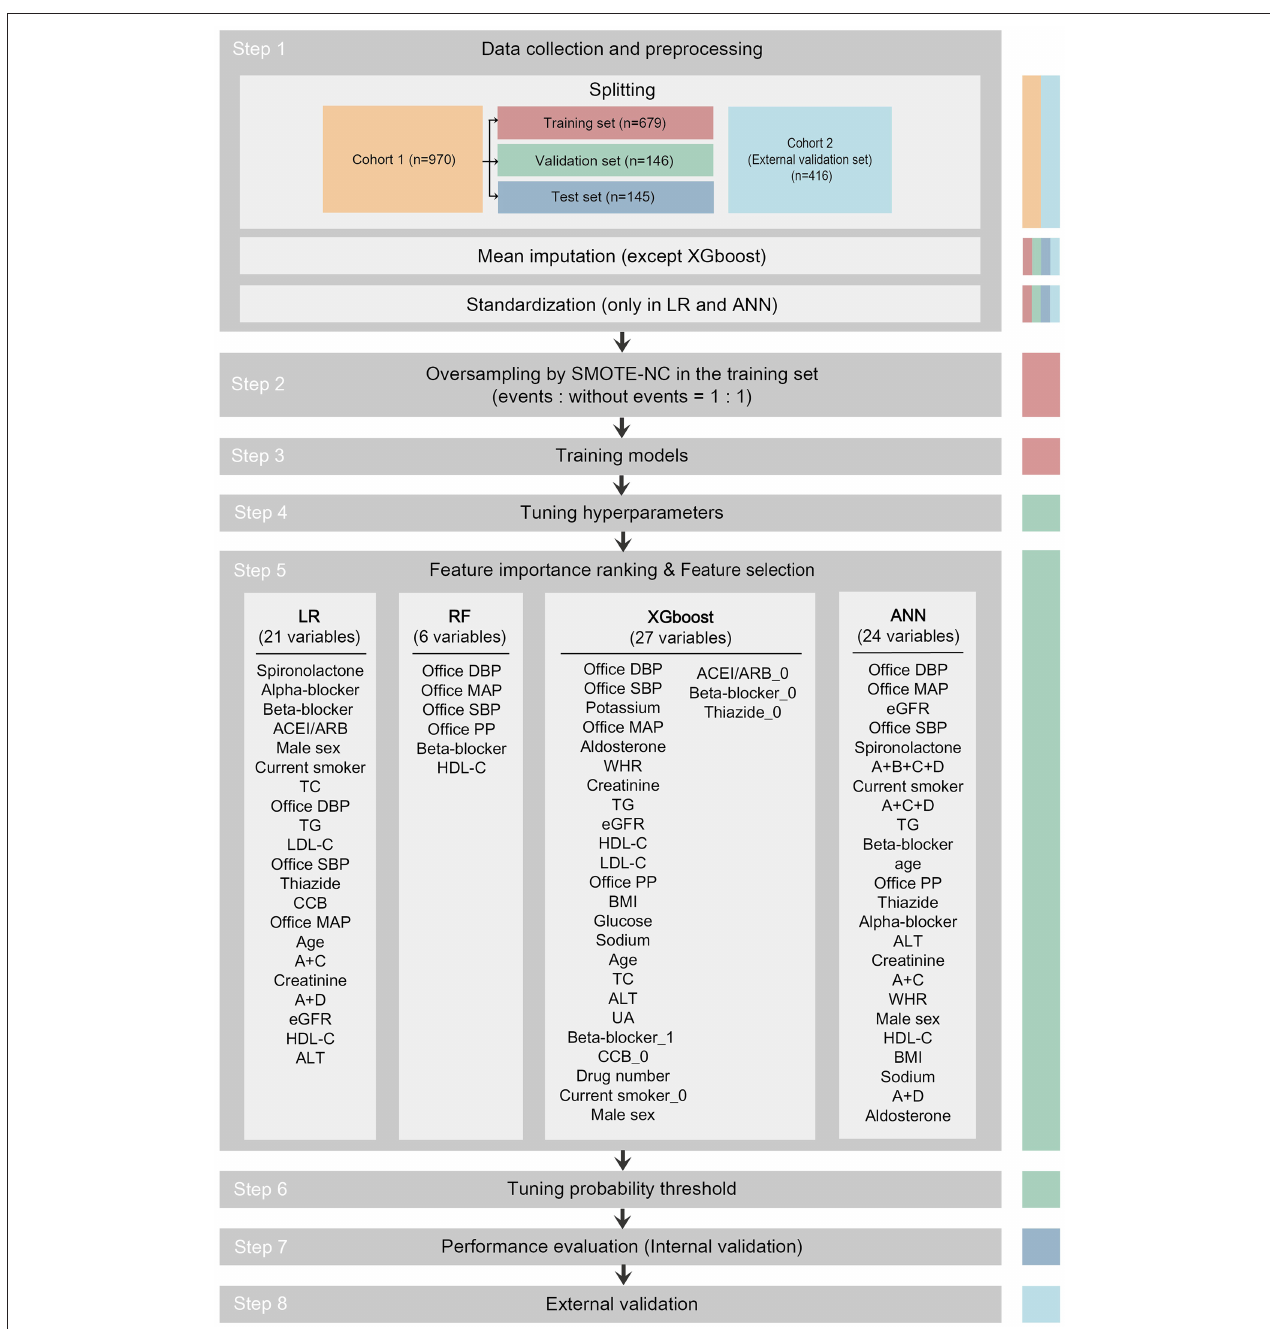
FIGURE 1 | Study flowchart. The data set used in each step is indicated as colored columns on the right side (training set for step 2 and 3, validation set for step 4 to 6, test set for step 7, cohort 2 for step 8). Mean imputation was done to all data sets using the mean of the training set in the LR, RF, and ANN models after splitting. Standardization was done to all data sets in the LR and ANN models after mean imputation. In step 5, 21 among 33 candidate variables were selected as predictor variables in the LR model, 6 in RF, 27 in XGboost, and 24 in ANN. The predictor variables were written in descending order of importance. ACEI/ARB, angiotensin-converting enzyme inhibitor/angiotensin receptor blocker; ACEI/ARB_0, dummy variable of not taking ACEI/ARB; A + B + C + D, combination of ACEI/ARB and beta-blocker and CCB and thiazide; A + C, combination of ACEI/ARB and CCB; A + C + D, combination of ACEI/ARB and CCB and thiazide; A + D, combination of ACEI/ARB and thiazide; ALT, alanine aminotransferase; ANN, artificial neural network; Beta-blocker_1, dummy variable of taking beta-blocker; Beta-blocker_0, dummy variable of not taking beta-blocker; BMI, body mass index; CCB, calcium channel blocker; CCB_0, dummy variable of not taking CCB; Current smoker_0, dummy variable of not current smoker; DBP, diastolic blood pressure; eGFR, estimated glomerular filtration rate; HDL-C, high-density lipoprotein-cholesterol; LDL-C, low-density lipoprotein-cholesterol; LR, logistic regression; MAP, mean arterial pressure; PP, pulse pressure; SMOTE-NC, synthetic minority oversampling technique–nominal continuous; Thiazide_0, dummy variable of not taking thiazide; RF, random forest; SBP, systolic blood pressure; TC, total cholesterol; TG, triglyceride; UA, uric acid; WHR, waist-to-hip ratio; XGboost, eXtreme Gradient Boosting.